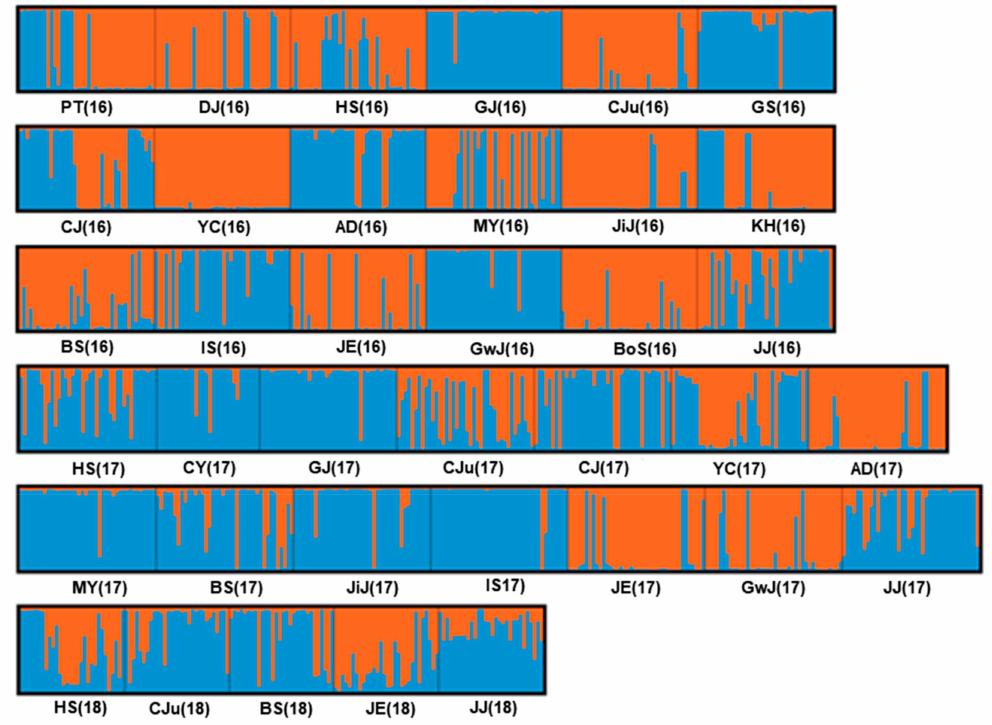
Figure 2. Structure profile under K = 2, permuted in CLUMPP, plotted with DISTRUCT on 37 A. gossypii populations, depicting classifications with the highest probability under the model that assumes independent allele frequencies and inbreeding coe ffi cients among assumed clusters. Each individual is represented by a vertical bar, often partitioned into colored segments with the length of each segment representing the proportion of the individual’s genome from K = 2 ancestral populations. On the bottom of the plot, the name of population localities is indicated and the year of sampling is shown in